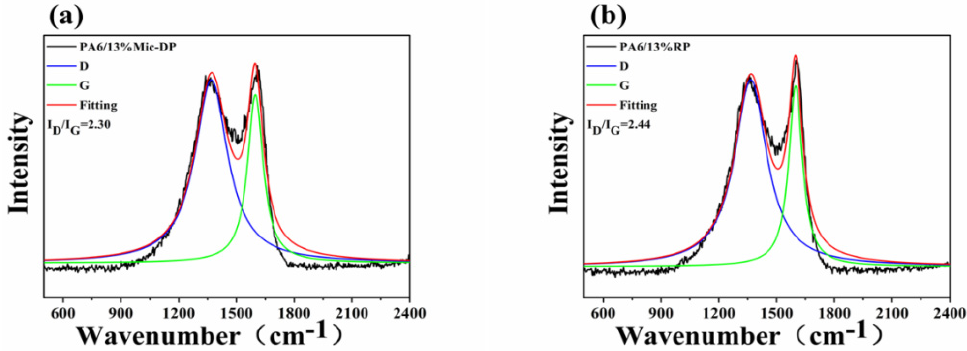
Figure 8. Raman spectra of the residual chars of ( a ) PA6/13%Mic − DP and ( b ) PA6/13%RP.